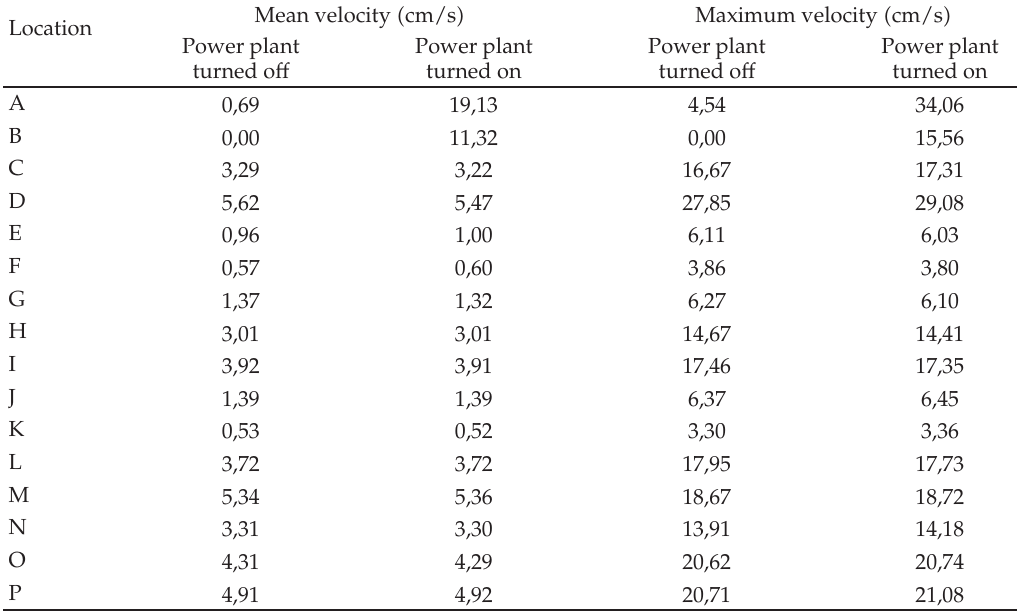
Figure 17: Time evolution of the water temperature calculated with the model in the zone outside the port (cid:3) point H (cid:4) with the power plant turned on and turned o ff . Histogram of the Δ T in point H. Table 2: Mean and maximum velocity calculated for the model in di ff erent locations of the Montevideo Bay considering the power plant turned o ff and turned